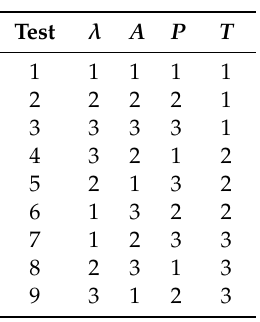
Figure 3. Schematic diagram of the orthogonal test method (OTM). Table 1. OTM tests.